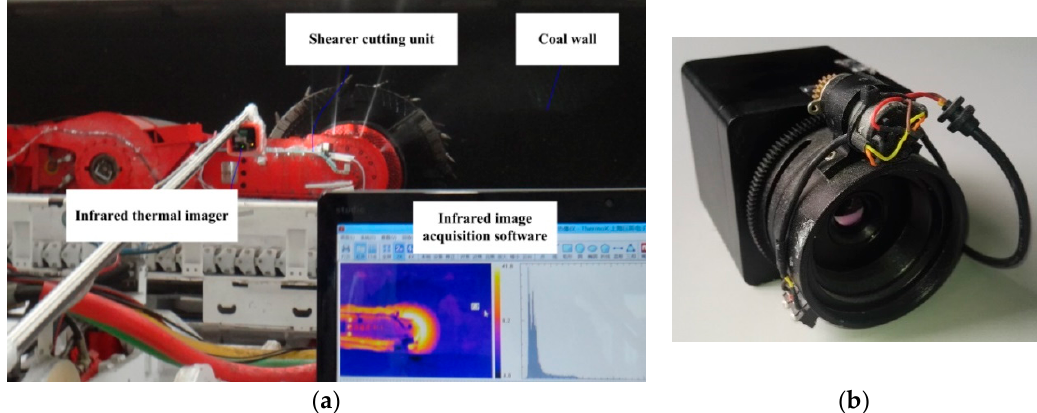
Figure 9. Built experimental system: ( a ) overall layout of experimental platform; ( b ) infrared thermal imager.